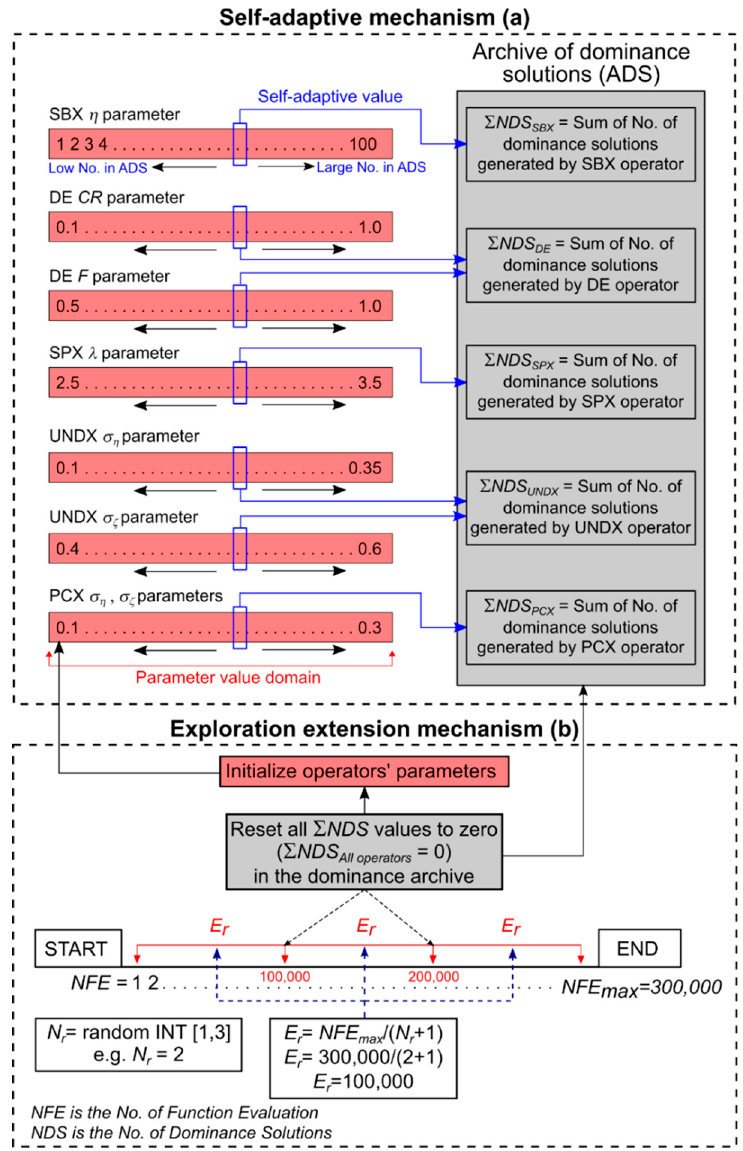
Figure 2. Illustrates the self-adaptive mechanism ( a ) and exploration extension ( b ) used by ε